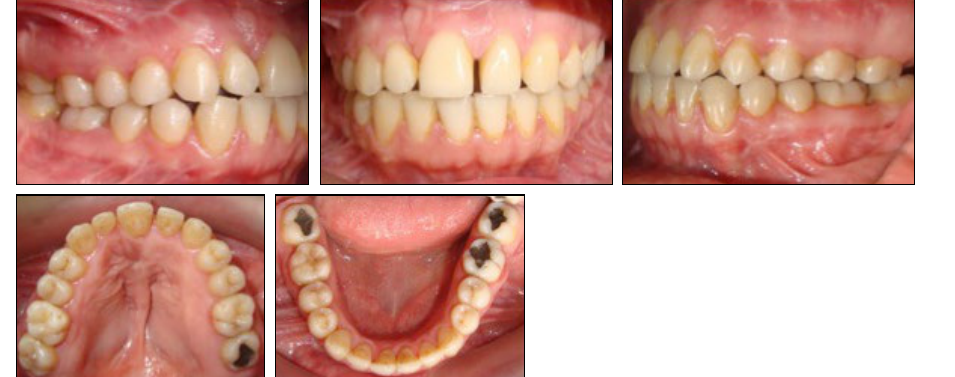
Figure 3. Pre-surgical facial and intraoral photographs.